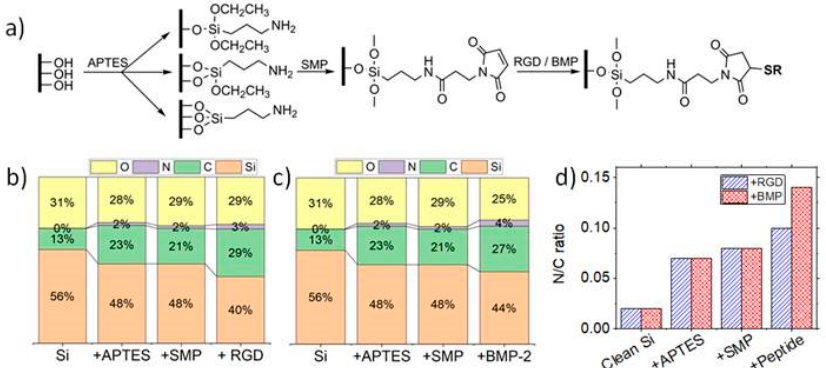
Figure 1. ( a ) Schematic representation of surface functionalization process. R represents the peptide of interest bound to the crosslinker SMP. This selective binding occurs between the maleimidyl group of the crosslinker and the thiol group only available in the cysteine (for both peptides). ( b – d ) chemical surface composition determined by XPS ( b , c ) stacked column plots show changes in elemental composition with each step of surface functionalization expressed as relative changes to the Si, C, N and O for ( b ) RGD or ( c ) BMP-2 peptides and ( d ) evolution of N/C ratios corresponding to each step of grafting on flat silicon surfaces.